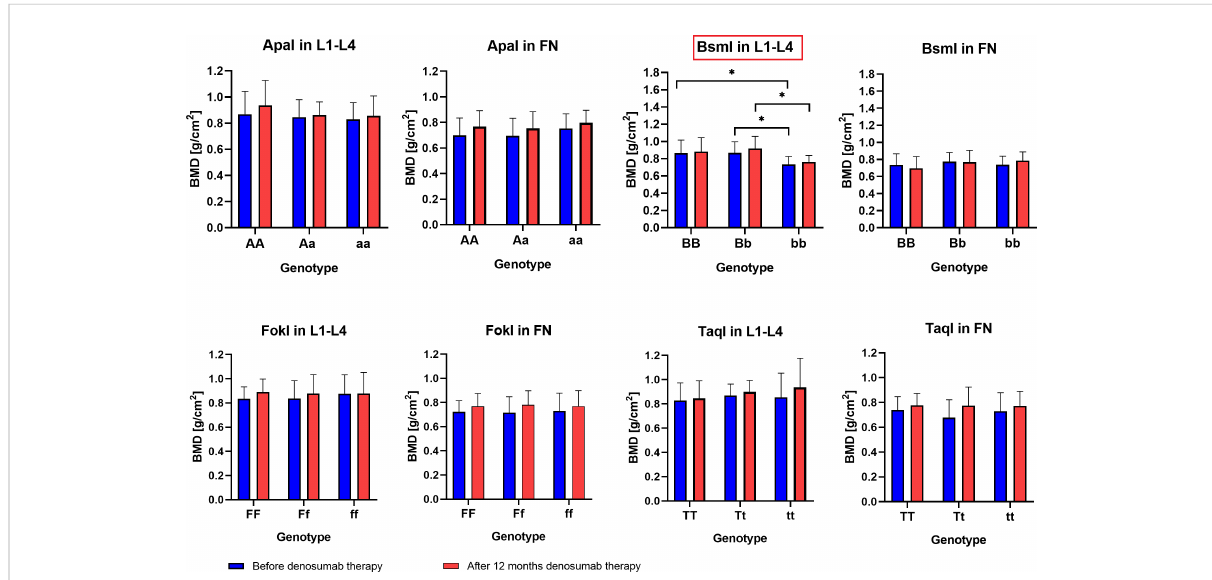
FIGURE 2 BMD results in the femoral neck (FN) and L1 – L4 area for ApaI , BsmI , FokI , and TaqI genotypes of the VDR gene in a studied group before and after one year of denosumab therapy (*P < 0.05).